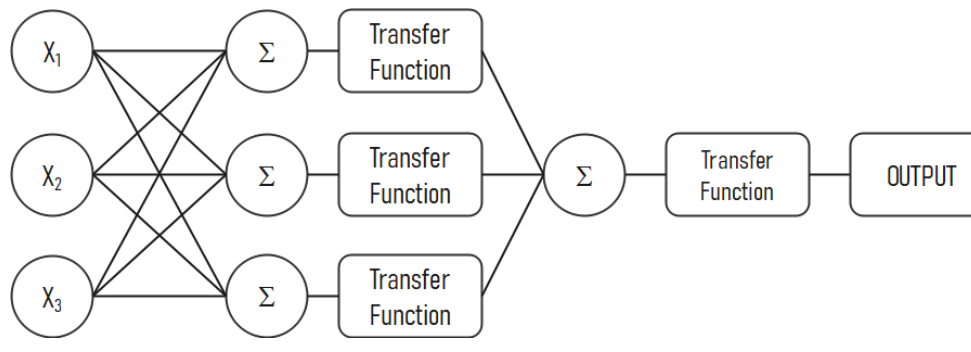
Figure 8. Multilayer